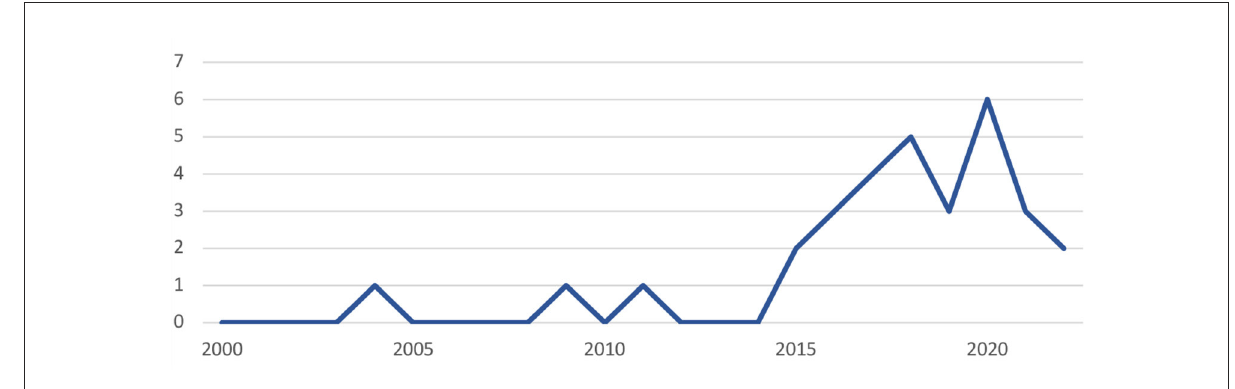
FIGURE2 Number of publications by year (Till 20